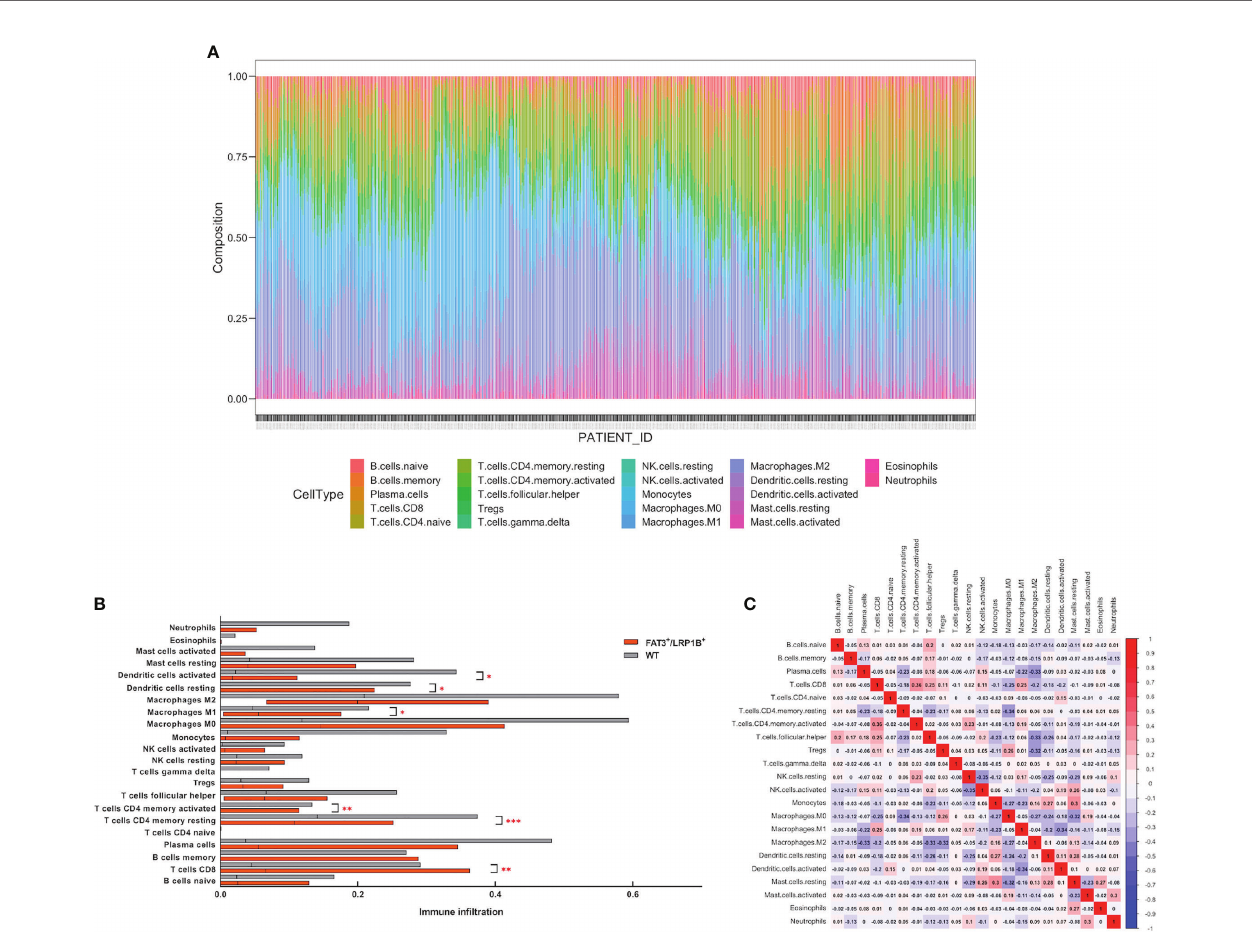
FIGURE 6 | Co-mutation of FAT3 and LRP1B can affect the degree of lymphocyte in fi ltration in LUAD. (A) The proportion of 22 immune cells in each sample in the LUAD dataset. (B) Differential tumor-in fi ltrating immune cells between FAT3 + /LRP1B + group and wild-type group. (C) Correlation analysis of immune cell abundance in tumor microenvironment. Red represents positive correlation, blue represents negative correlation. p values indicate comparisons between FAT3 + /LRP1B + and wild-type LUADs by Mann-Whitney test. *p < 0.05, **p < 0.01, ***p <